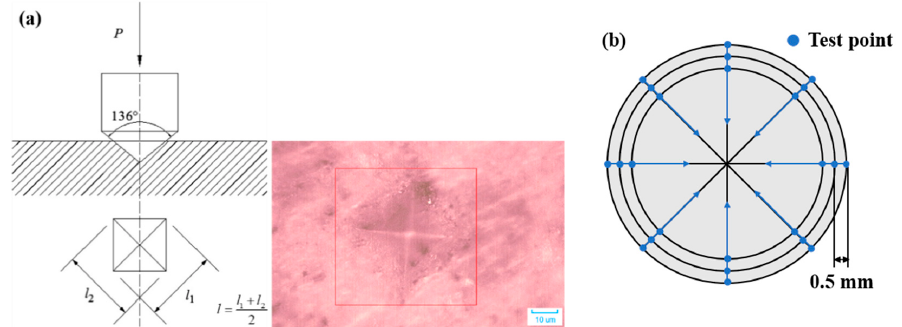
Figure 4. Schematic diagram (a) and the grid points (b) of Vickers hardness test.